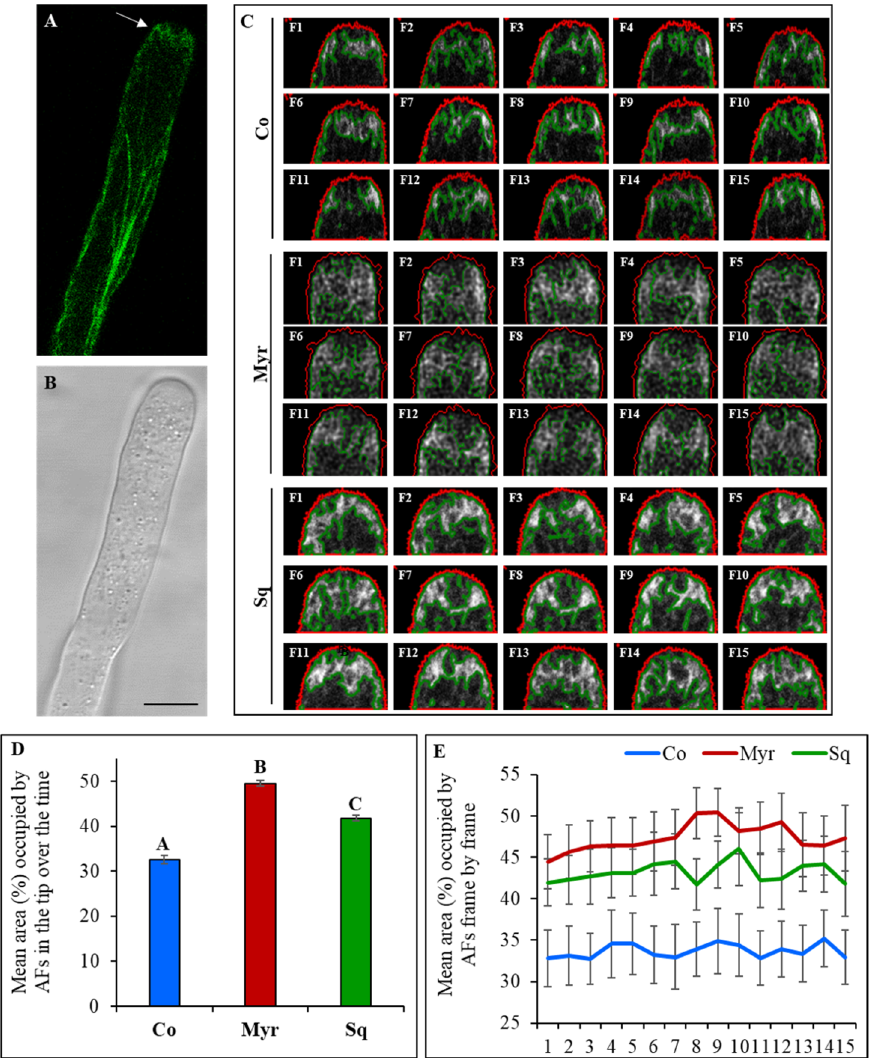
Figure 3. Effect of myriocin and squalestatin on actin fringe dynamic. Pollen grains were transiently transformed with a plasmid which codifies for the fusion protein Lifeact-EGFP under the control of the pollen specific promoter LAT52. In control pollen tubes in the shank and distal regions, actin longitudinal bundles were observed (( A ) pLAT52-Lifeact-EGFP, ( B ) bright field). In the apical flanks (2–5 μ m from the apical PM), short, dynamic AFs organized into a fringe (( A ), see arrow). Since AFs longitudinal bundles were not affected by myriocin and squalestatin, analyses of cortical actin fringe in control, myriocin and squalestatin-treated pollen tubes were performed ( C ). Images were deconvolved with Huygens professional version 19.04 software and processed with CellProfiler software. ROI in red defines first 5 μ m of pollen tube and area occupied by AFs is defined by the green line ( C ). The percent area (%) occupied by AFs in each tip is calculated and the mean value represented for each treatment showing higher percentage in myriocin and squalestatin-treated cells, with respect to control tubes (( D ); ANOVA and Tukey’s post hoc test: p < 0.001 for Myr and p = 0.0055 for Sq; n > 11). Comparisons of the mean area occupied by AFs over time show that this difference is significant for each frame ( E ). Scale Bar = 10 μ m.